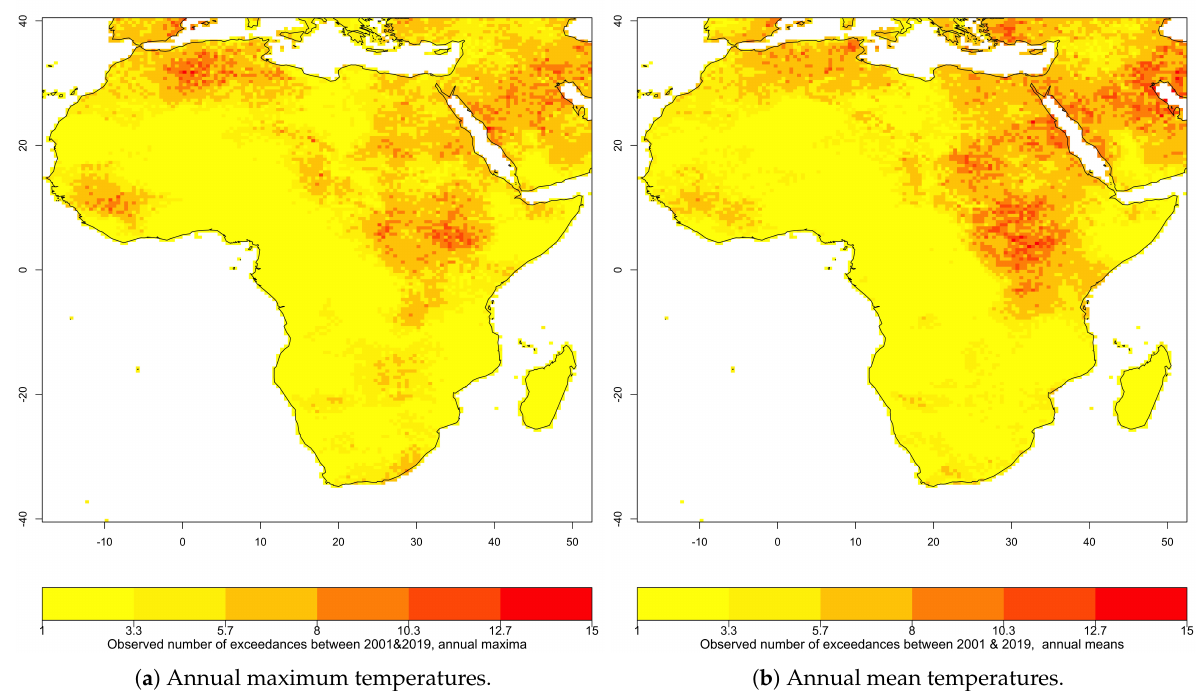
Figure 6. Observed number of exceedances of the 20th century threshold, between 2001 and 2019, in ( a ) annual maximum temperatures and ( b ) annual mean